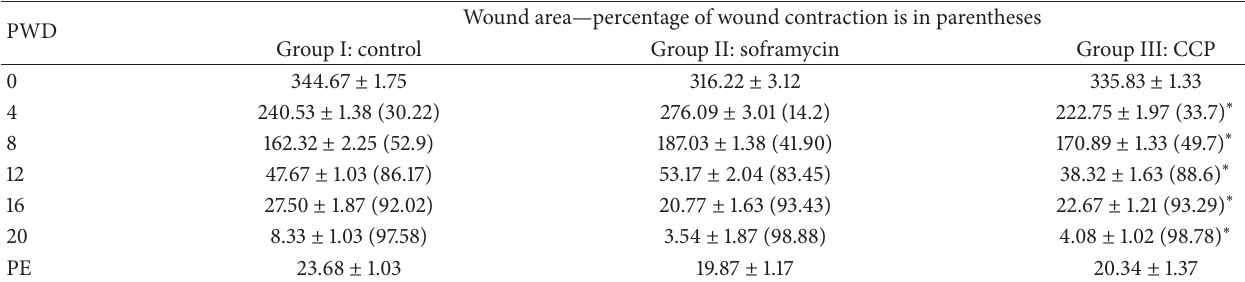
Table 5: Effect of protease on excision wound parameter in mice.